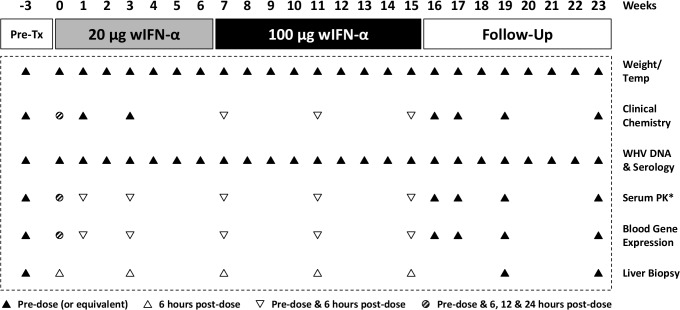
Design of the wIFN-α treatment study in woodchucks chronically infected with WHV.Chronic WHV carrier woodchucks were dosed three times a week (TIW) for 15 weeks with placebo, or for 7 weeks with 20 μg wIFN-α followed by another 8 weeks with 100 μg wIFN-α (15 weeks total). Animals were typically followed for additional 8 weeks after the treatment period (follow-up), although this was extended by two weeks for two wIFN-treated woodchucks (animals M1002 and M1004) that had no evidence of viral recrudescence at the end-of-study (week 23). *PK analysis of serum wIFN-α levels was not performed due to the lack of a sufficiently sensitive quantitative method (see Methods).